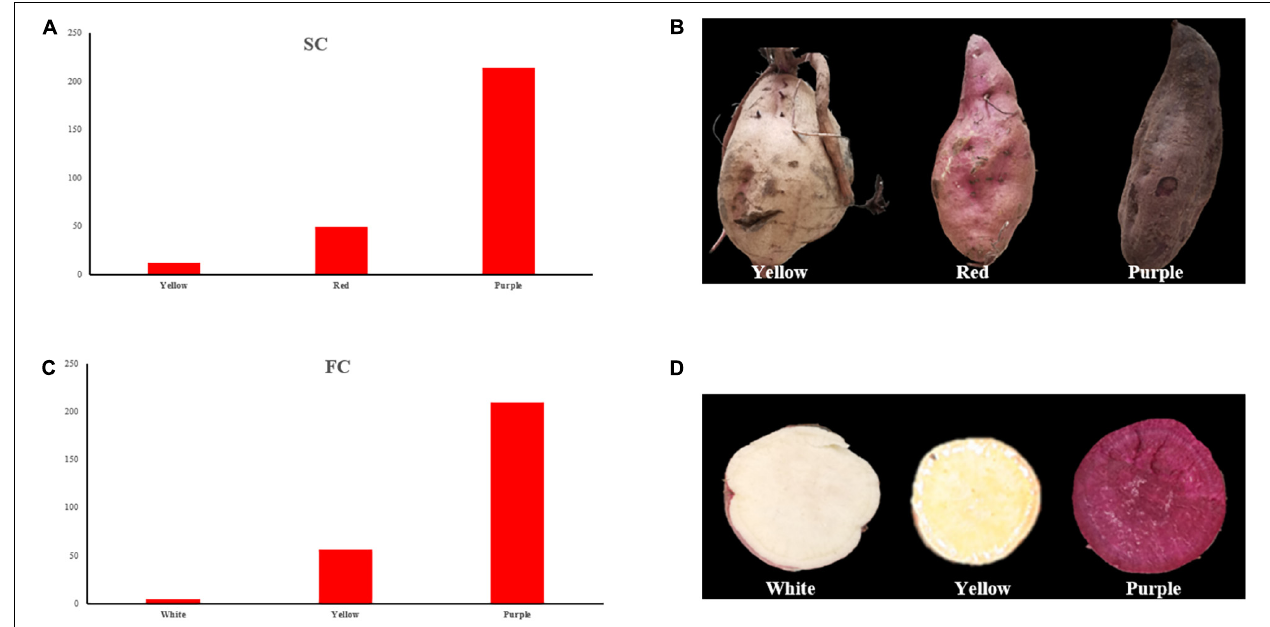
FIGURE 2 | Frequency distribution of SC and FC. (A) SC frequency distribution of the individuals; (B) three skin color types of the individuals; (C) FC frequency distribution of the individuals; (D) three flesh color types of the individuals. SC, skin color; FC, Flesh color.